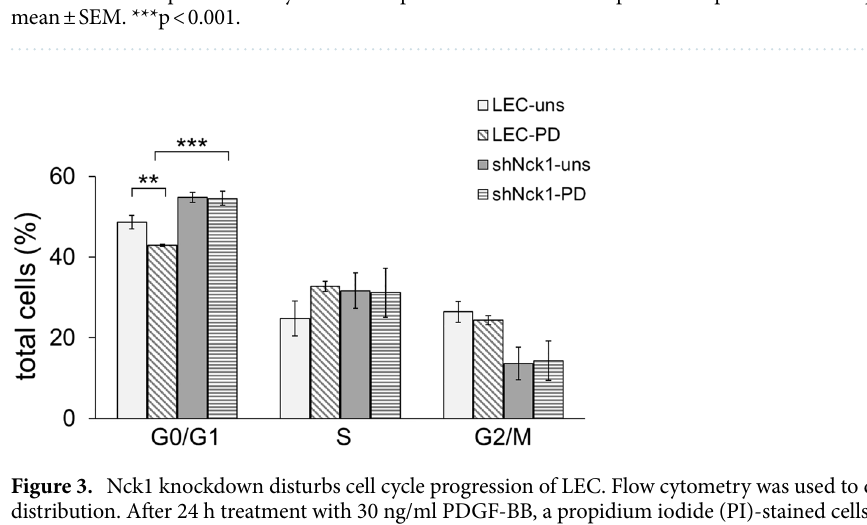
Figure 2. Knockdown of Nck1 adaptor protein suppresses PDGF-BB-induced LEC proliferation. LEC and shNck1 LEC were either stimulated with 30 ng/ml PDGF-BB or left untreated at 37 °C for 24 and 48 h. BrdU was added to the cells at a final concentration of 10 μM. Cell proliferation was examined using ELISA- based BrdU incorporation assay. Data are representative of four independent experiments and represent the mean ± SEM. ***p < 0.001.